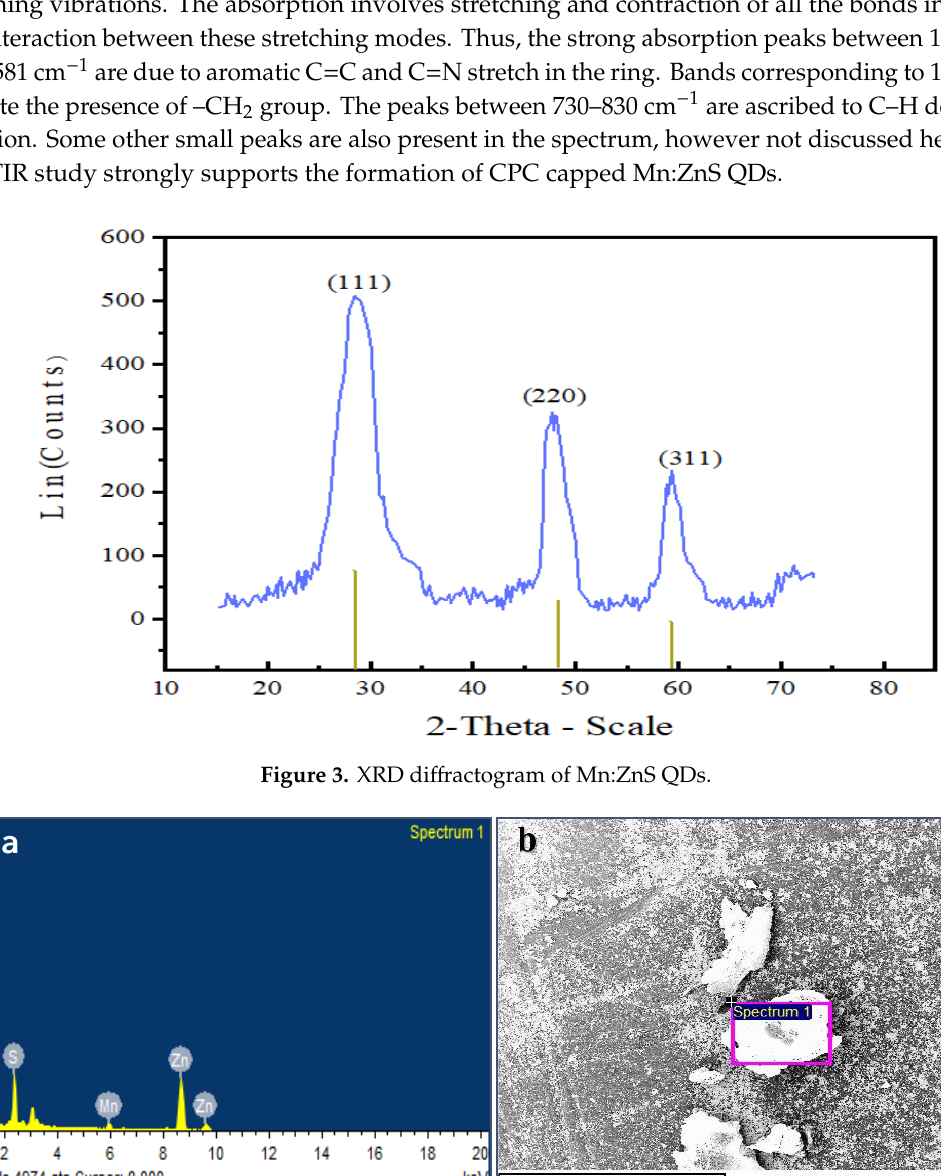
Figure 4. SEM image of Mn:ZnS QDs ( a ) with respective EDS pattern ( b ).